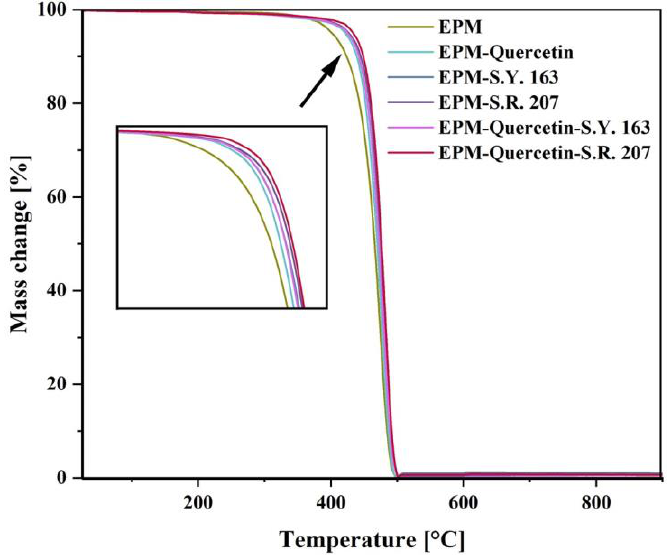
16 of 24 Figure 11. The surface energy of ethylene-propylene materials with specific colorants, calculated by the Owens–Wendt–Rabel–Kealble method before and after 200 and 400 h of ( a ) thermo-oxidation, ( b ) climatic aging. 2.2.3. Thermal Properties Thermal analysis plays a key role in assessing the polymer additives stability. Dyes and other used components must be resistant to the polymer processing conditions and further environmental factors. Figure 12 and Table 2 show the thermal stability data for ethylene-propylene rubber with different colorants determined by the thermogravimetric analysis (TGA). As it can be observed, the incorporation of dyes in the amount of 1.5 phr had a significant impact on the thermal stability of the tested composites. For all samples with natural and/or synthetic dye content, a delay in the thermal degradation process has been observed. The excellent thermal resistance of these compounds is generally due to their crystalline structure. In the case of the EPM-quercetin-S.R. 207 sample, the tempera- ture where weight loss was equal to 5% was 433 °C, while for EPM-S.R. 207 material was 427 °C and for pure EPM rubber was 401 °C. This improvement can be related to the na- ture and position of the substituents presented in these compounds. According to the lit-